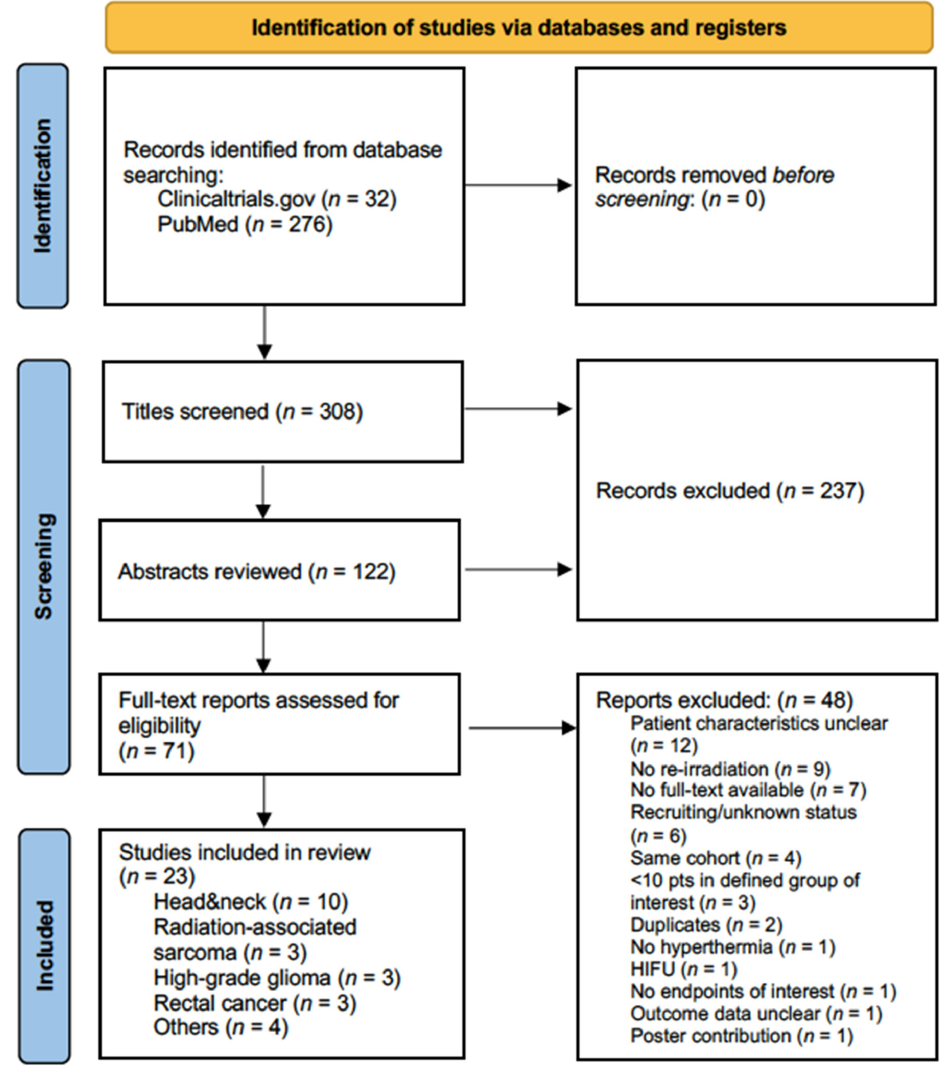
Figure 1. PRISMA flow diagram of the literature